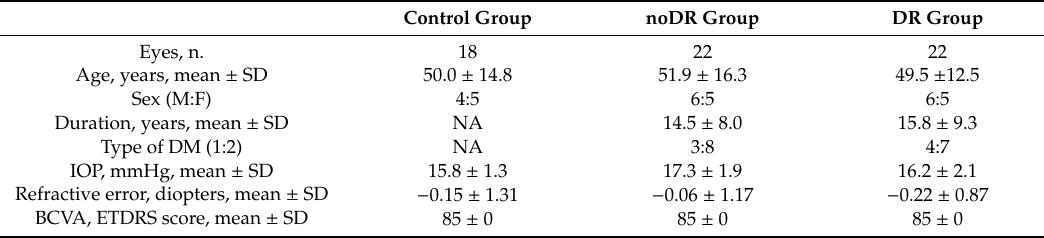
Table 1. Demographic characteristics of the enrolled population.